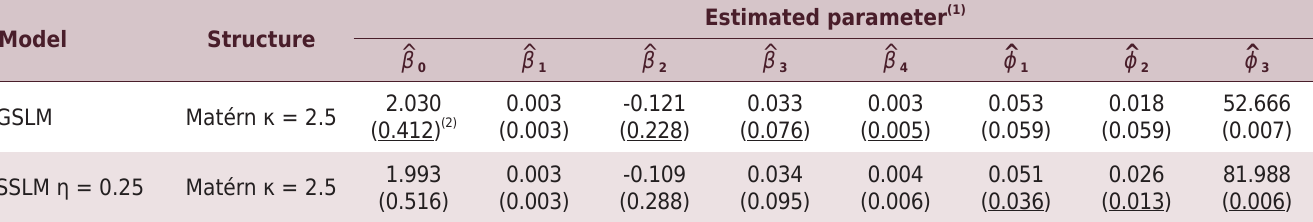
Table 2. Values of parameters for kurtosis adjustment (η) and of smoothing (κ) selected from CrV (Cross-validation) and Tr (Trace) criteria; estimated values of parameters of the Gaussian spatial linear model (GSLM) and slash spatial linear model (SSLM) by maximum likelihood using the EM algorithm with respective asymptotic standard deviations (in